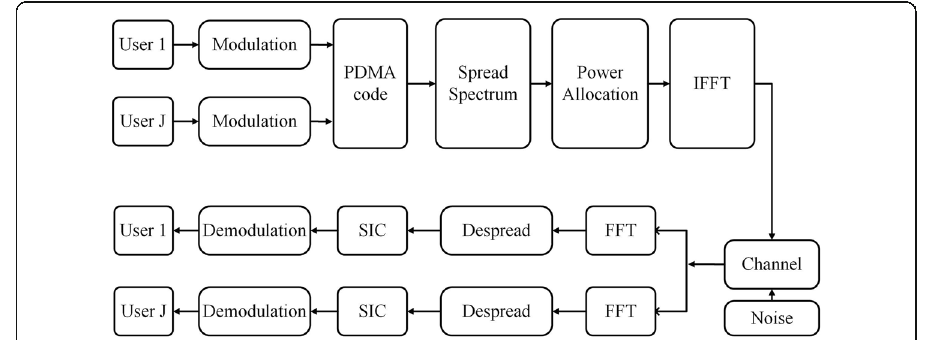
Fig. 2 System model. The spread spectrum and power allocation system model based on